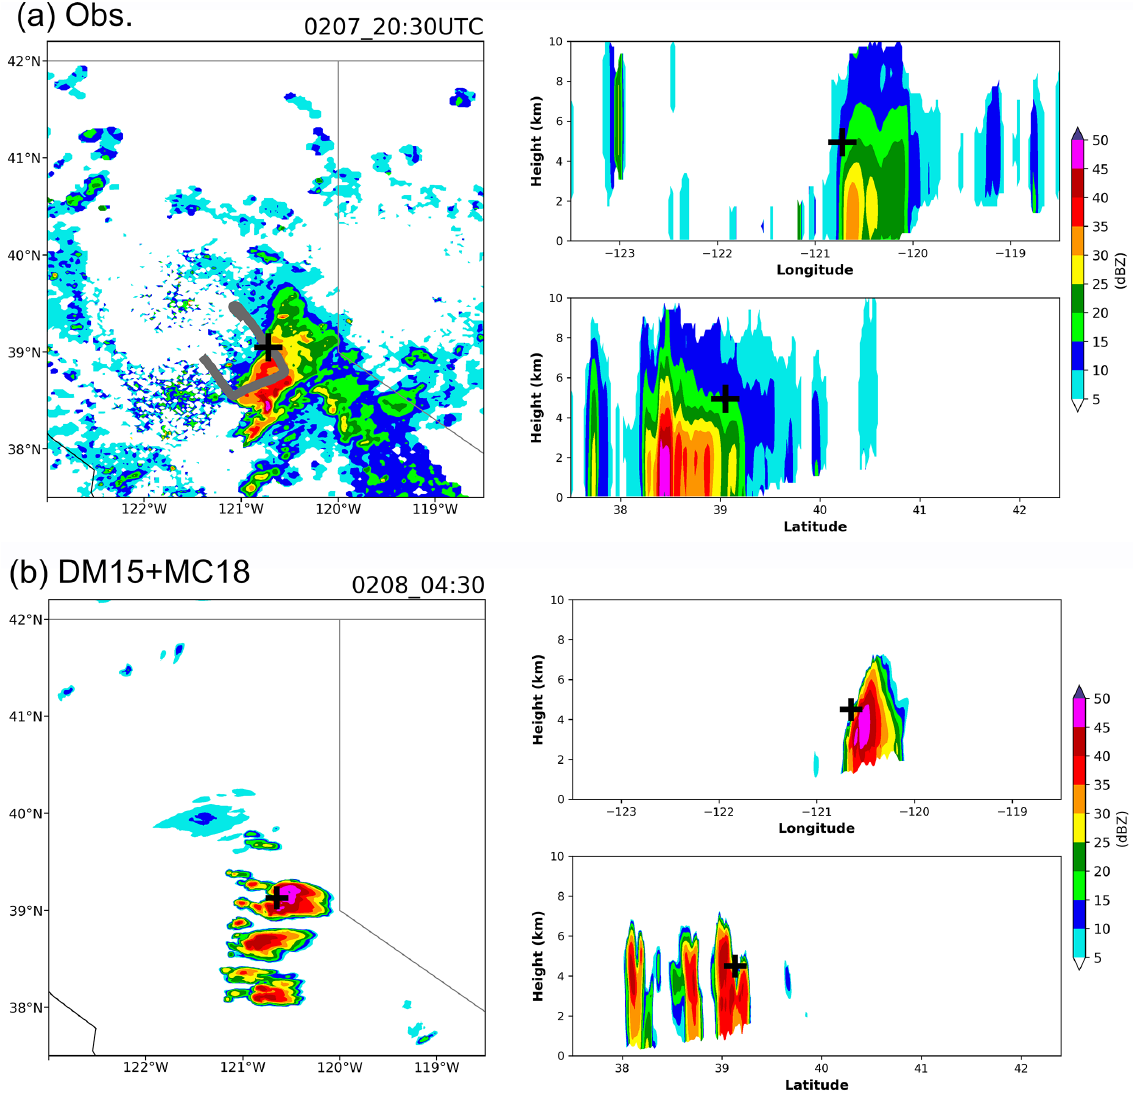
Figure 5. (a) Composite reflectivity of NEXRAD for the postfrontal clouds that the G-1 aircraft sampled, (b) composite reflectivity from the simulation of DM15 + MC18 for the postfrontal clouds. The observation and simulation are compared at the peak reflectivity time which is 20:30 UTC on 7 February for the observed clouds and 04:30 UTC on 8 February for the simulated clouds. The black crosses in the two left panels denote the positions where the longitude–height and latitude–height cross sections in the right panels are plotted. The gray line in the left panel of (a) shows the flight track of the G-1